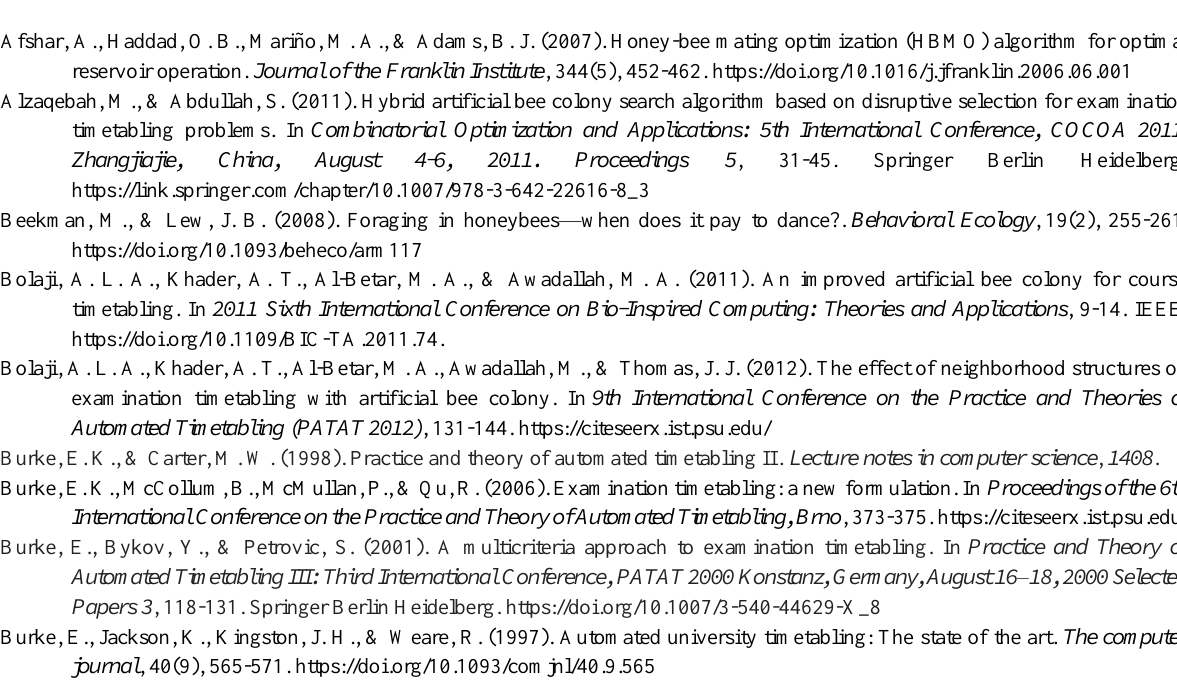
The tested Performance metric as shown in table 1 above represents the speed of emergence of a swarm of bee-like robotic devices which uses a BSet model. This is measured in terms of the time (iterations) it takes a swarm of bee-like robotic devices to identify and extract 115 examinable modules and their related attributes for timetabling. The time taken by the robotic devices to find the examinable module is measured in terms of iterations as shown in figure 8 and figure 10. High performances are represented by fewer iteration value attained by the robotic devices to find the examinable module. Low performances, on the other hand, corresponds to a higher number of iterations executed before the target is located. Figure 8 shows 4750 iterations made by 10 robotic devices to complete the extraction of 115 examinable modules and Figure 12 shows 789 iterations made by 100 bee-like robotic devices to complete extraction of 115 examinable